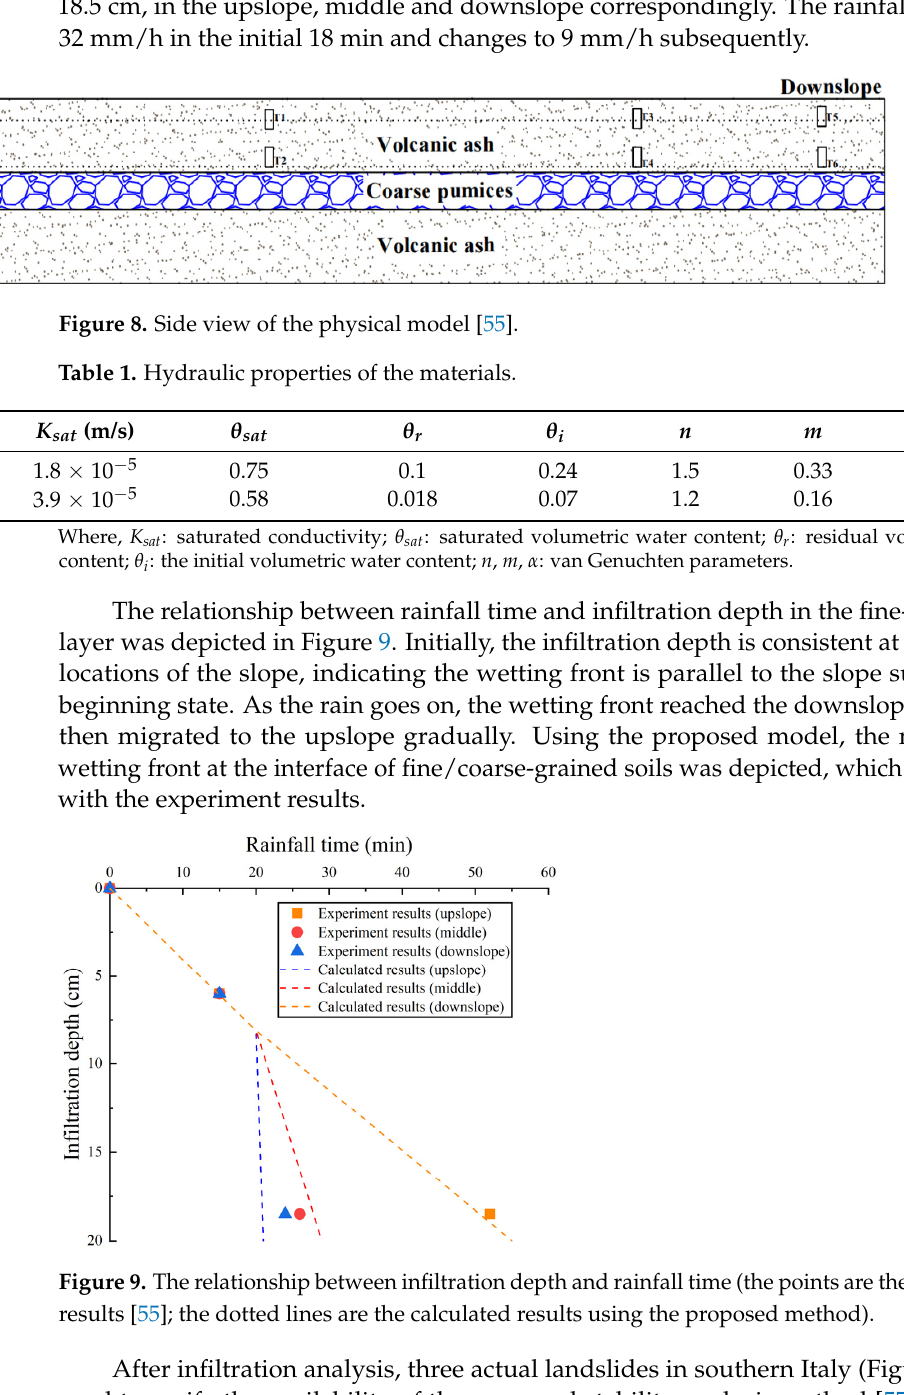
Table 2. Main physical and mechanical properties of the materials of three slopes.